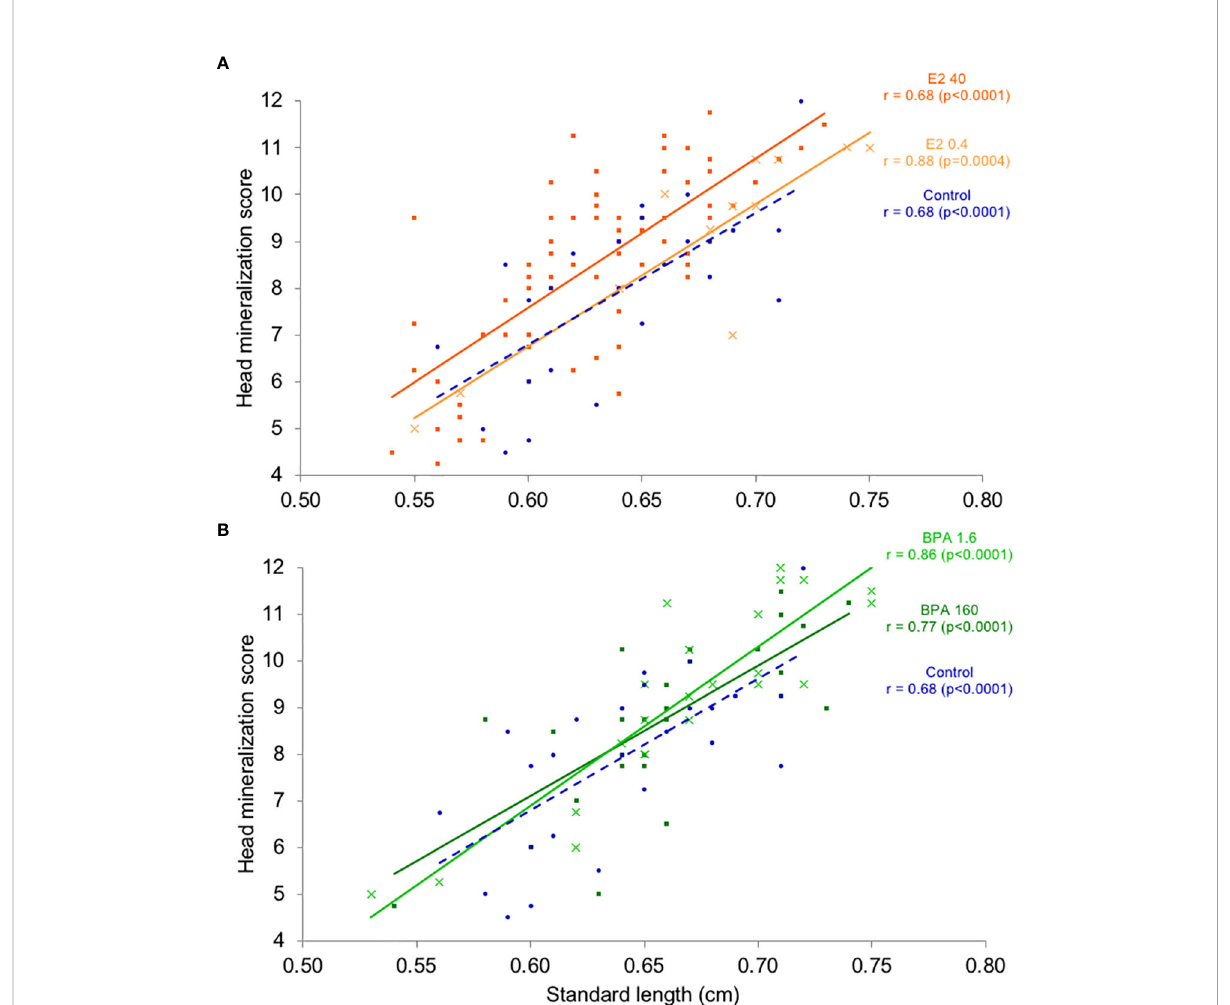
FIGURE 3 Distribution of head mineralization level as a function of the fi sh standard length (cm) in 16-dph individuals exposed for 4 days at nominal concentrations of E2 0.4 and 40 ng.L -1 (A) , BPA 1.6 and 160 m g.L -1 (B) and ethanol 0.0008% (v/v) as a solvent control (A, B) . Linear regression curves are shown to illustrate the linear relationship. Since data does not fi t normality assumption, a non-parametric Spearman ’ s correlation coef fi cient r was calculated to evaluate the strength and the direction of the monotonic relationship. A nonparametric analysis of covariance was used to test the difference between two treatments. The p-value is given in the table (ns, not signi fi cant according to the Bonferroni adjusted p<0.017